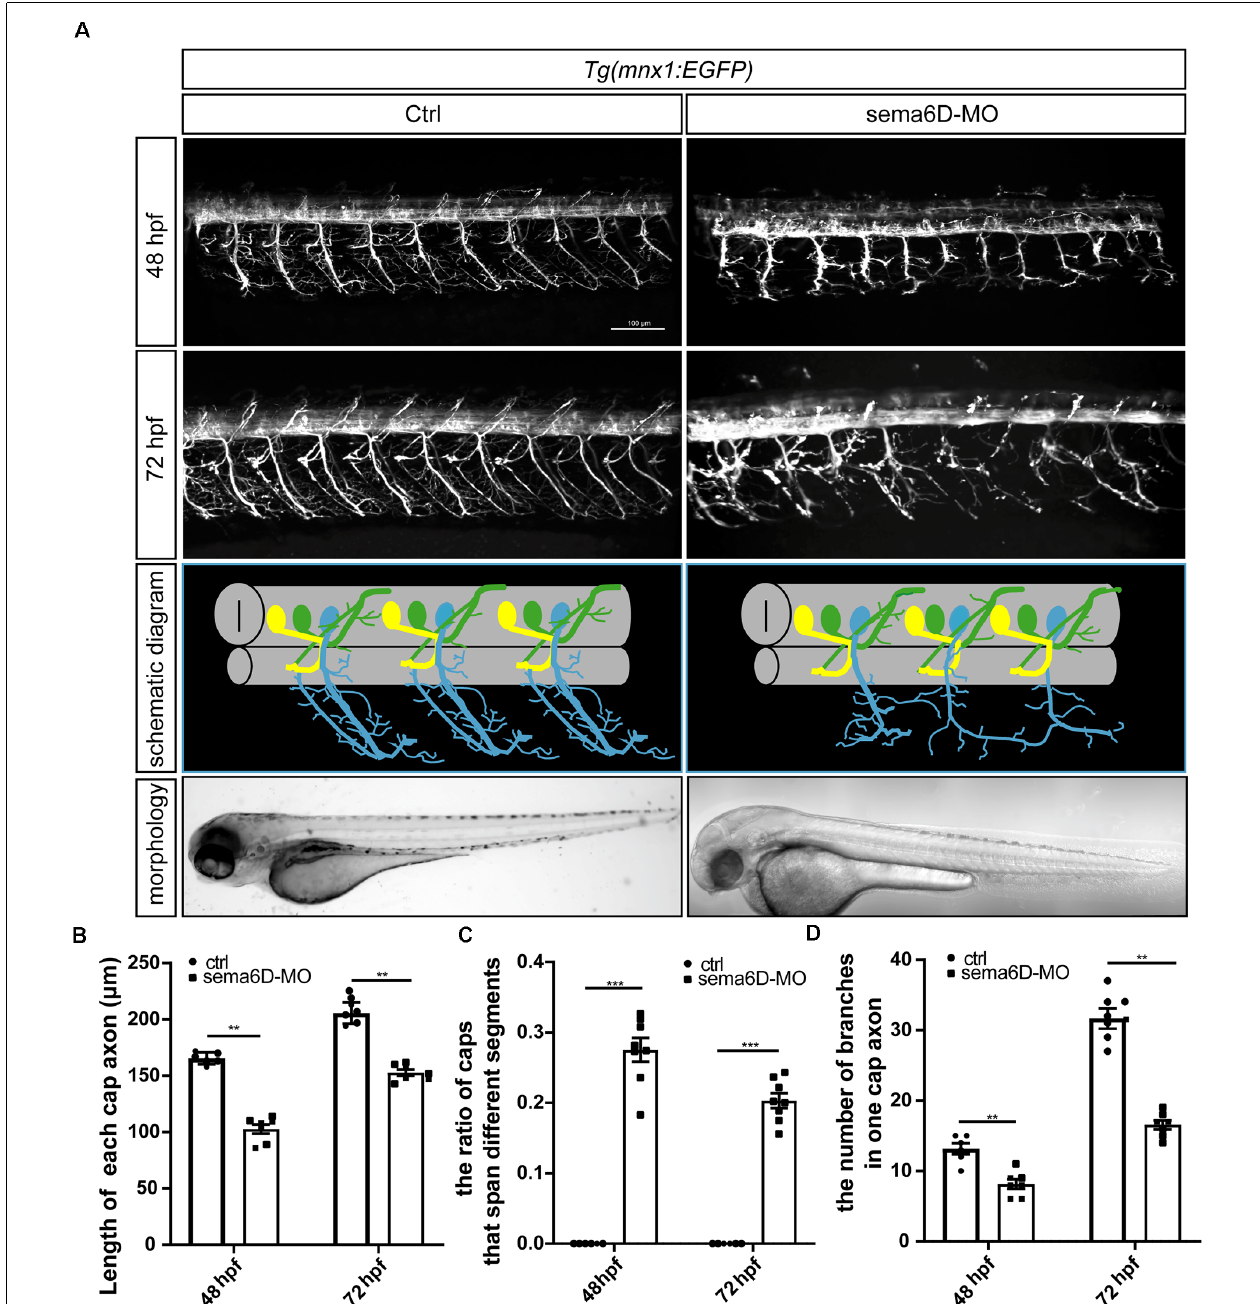
FIGURE 3 | Primary motor neuron morphogenesis defects in the sema6D knockout zebrafish. (A) Confocal imaging analysis of PMNs in control and sema6D knockout groups at 48 and 72 hpf. (B) The statistical analysis of the length of each cap axon in the control and sema6D morphants at 48 and 72 hpf ( n = 7). The length of five cap axon was measured in each zebrafish and the average was used. Mann-Whitney test, P = 0.0012. Values with ** above the bars are significantly different ( P < 0.01). (C) The statistical analysis of the ratio of Caps across different segments in the control and sema6D morphants at 48 and 72 hpf ( n = 8). Mann-Whitney test, P = 0.0007. Values with *** above the bars are significantly different ( P < 0.001). (D) The statistical analysis of the number of branches in one cap axon in the control and sema6D morphants at 48 and 72 hpf. The number of branches in each cap axon was measured in five axon of each zebrafish and the average was used. Mann-Whitney test, 48 hpf: P = 0.0017; 72 hpf: P = 0.0012. Values with ** above the bars are significantly different ( P <